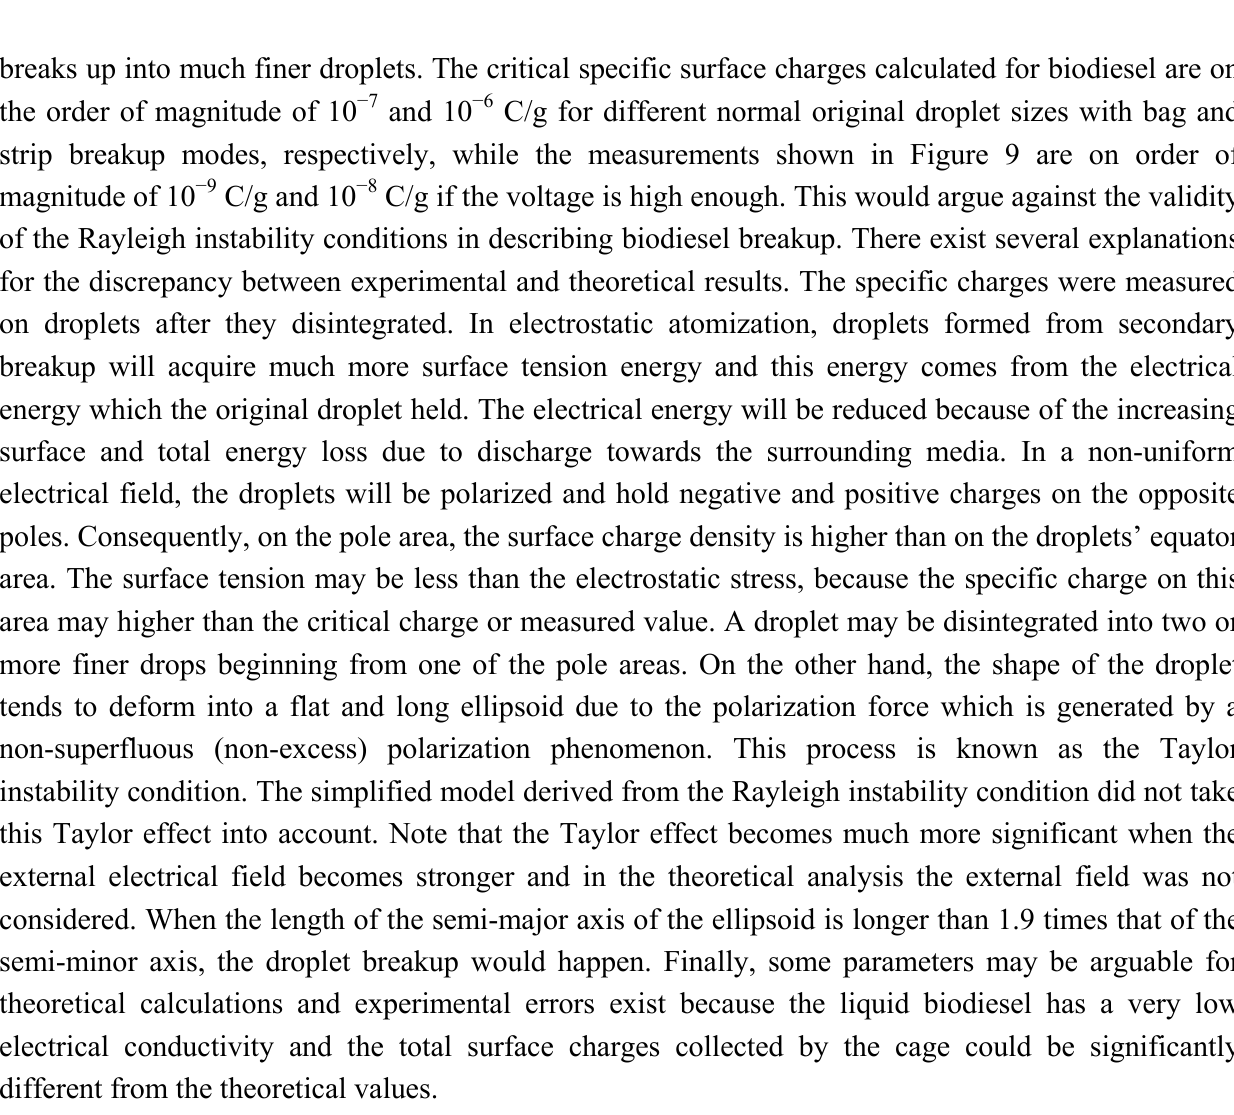
Figure 9. Correlations among the droplets size, applied voltage and specific surface